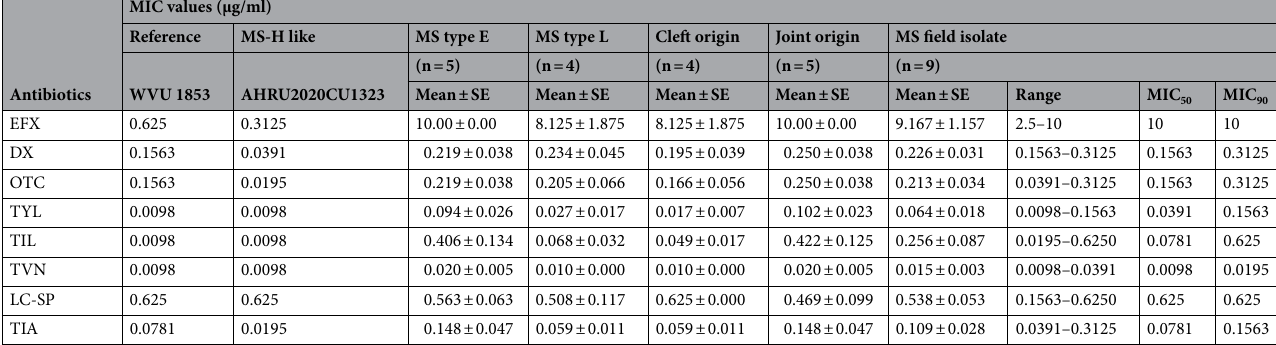
Table 4. The MIC value range, MIC 50, and MIC 90 of M. synoviae isolates in this study. Abbreviations of antibiotics: EFX Enrofloxacin, DX Doxycycline, OTC Oxytetracycline, TYL Tylosin, TIL Tilmicosin, TVN Tylvalosin, LC-SP Lincomycin-spectinomycin, TIA